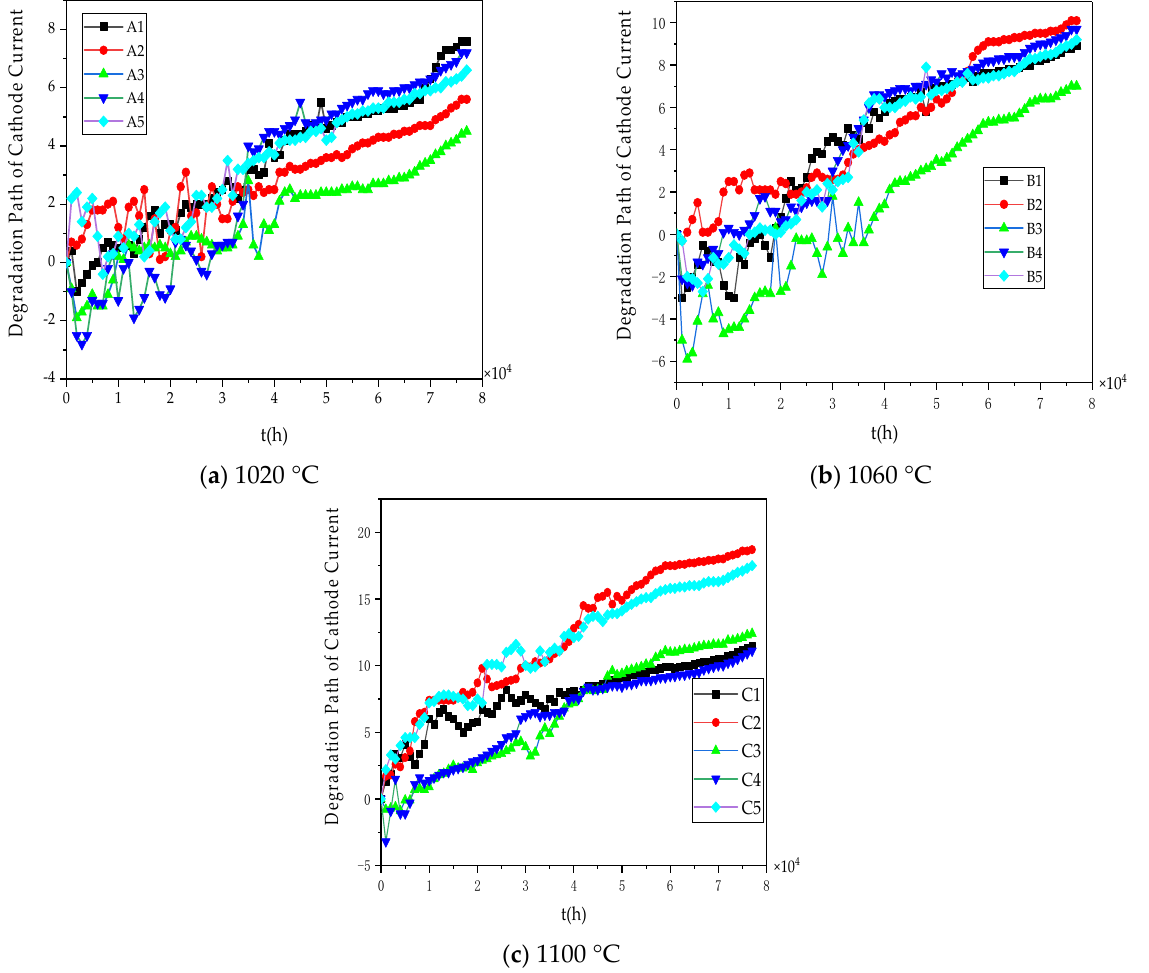
Figure 2. Degradation trajectory of cathode emission current at ( a ) 1020 °C, ( b ) 1060 °C, ( c ) 1100 °C. According to [29], the degradation rate of cathodes at a constant emission current can be described by the Arrhenius model. Therefore, we use a stochastic Arrhenius model to represent the acceleration model applied to determine the relationship between the failure time data and the working temperature stress. Based on the parameters estimation method proposed in Section 3, we can obtain the estimation results of parameters and the AIC as shown in Table 3, indicating that M 0 clearly outperforms other models in terms of AIC . It is shown that the proposed model has a better fit than the